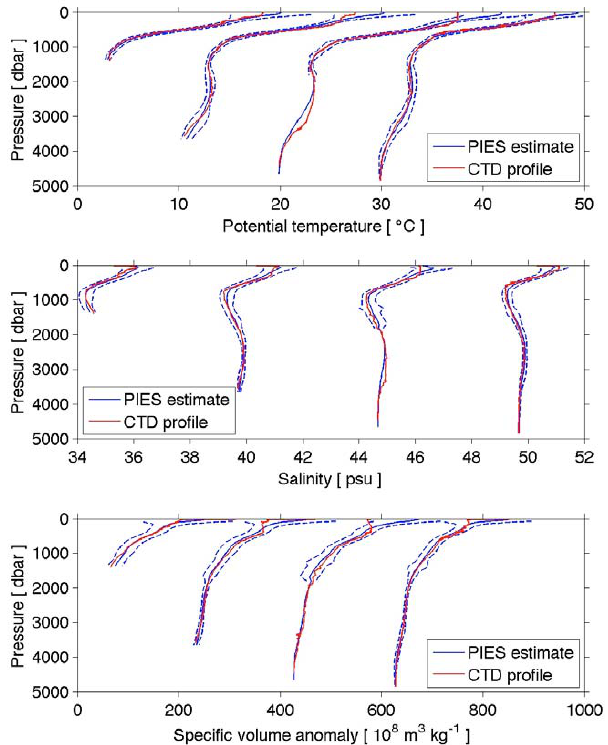
Fig. 5. Comparison of CTD profiles of potential temperature (up- per panel), salinity (middle panel) and specific volume anomaly Figure 5: Comparison of CTD profiles of potential temperature (upper panel), salinity (lower panel) collected at the four PIES/CPIES sites during the 20– (middle panel) and specific volume anomaly (lower panel) collected at the four 24 August 2009 cruise to the PIES-GEM estimated profiles aver- PIES/CPIES sites during the August 20-24, 2009 cruise to the PIES-GEM estimated aged over the same five days. Profiles were offset by 10 ◦ C, 5psu Figure 6: Upper panel – Time mean absolute meridional velocity determined between Fig. 6. Upper panel: time-mean absolute meridional velocity deter- profiles averaged over the same five days. Profiles were offset by 10 ° C, 5 psu and 200 x and 200 × 0 8 m 3 kg − 1 , respectively, to facilitate viewing; profiles pairs of PIES/CPIES along the array. Lower panel – Standard deviation of the time- mined between pairs of PIES/CPIES along the array. Lower panel: 10 8 m 3 kg -1 , respectively, to facilitate viewing; profiles are illustrated from west to east are illustrated from west to east (Sites A to D) across the array mov- varying absolute meridional velocity determined between the pairs of PIES/CPIES along standard deviation of the time-varying absolute meridional velocity (Sites A to D) across the array moving from left to right in the figure. Conductivity ing from left to right in the figure. Conductivity measurements by the array. Black dots along lower axis denote locations of the PIES/CPIES. determined between the pairs of PIES/CPIES along the array. Black measurements by the CTD were noisy due to a sensor problem; the data have been the CTD were noisy due to a sensor problem; the data have been smoothed vertically to remove small artificial vertical structures. CTD data are shown as dots along lower axis denote locations of the smoothed vertically to remove small artificial vertical structures. red solid lines, while PIES estimates are blue solid lines. Blue dashed lines represent CTD data are shown as red solid lines, while PIES estimates are 95% confidence estimates around the GEM profiles based on the observed scatter of the blue solid lines. Blue dashed lines represent 95% confidence esti- hydrographic data used to create the GEM fields. mates around the GEM profiles based on the observed scatter of the hydrographic data used to create the GEM fields.